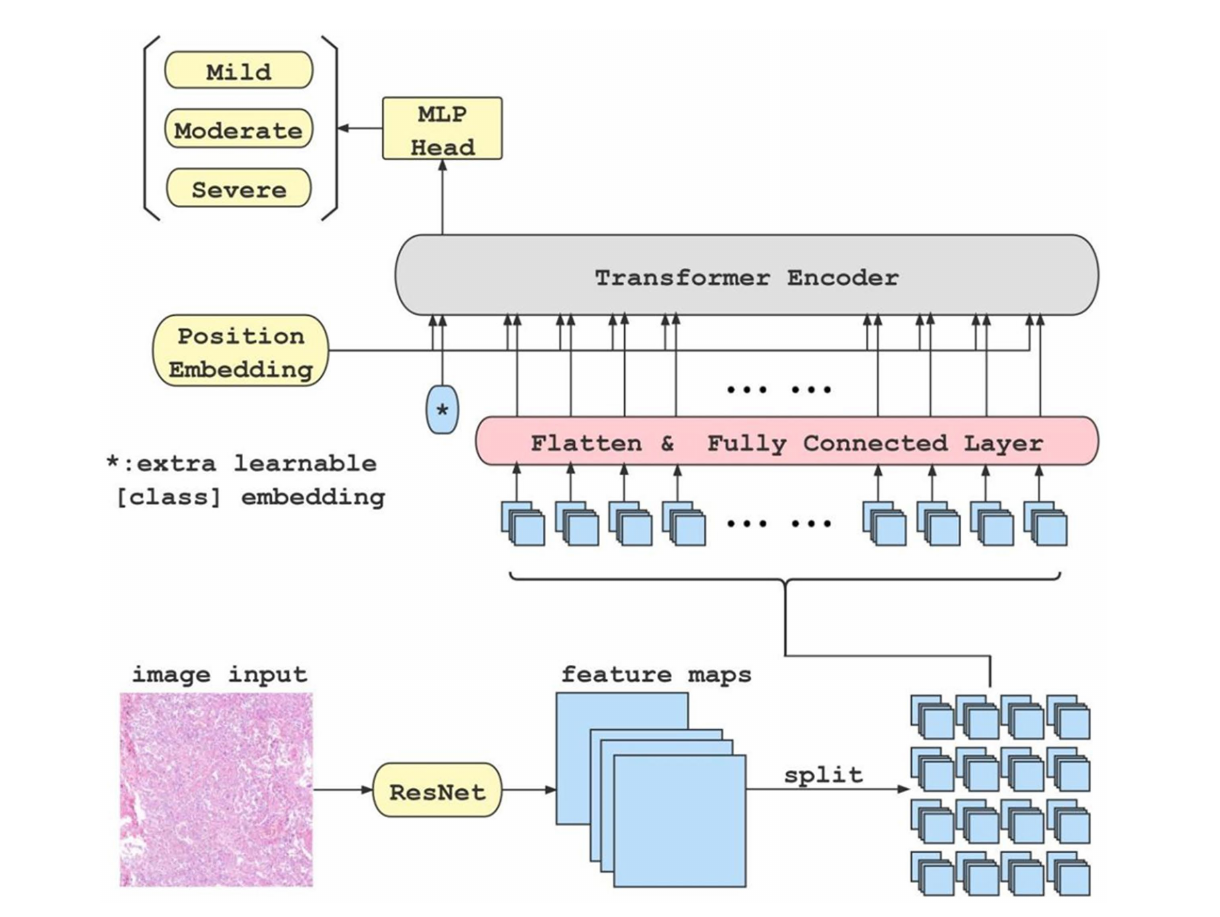
FIGURE 1 This is the flow chart of our classification model. When an original image is input to the ResNet feature extractor, the extractor outputs high- dimensional features maps of the image. Afterwards, the feature maps are split into blocks(in this case, there are 4 × 4 blocks), flattened, and fed into fully connected layer block by block. Meanwhile, a class token is initialized separately and fed into the transformer encoder together with each block of the output from the fully connected layer. Finally, the class token is extracted and fed into an MLP to get the classification